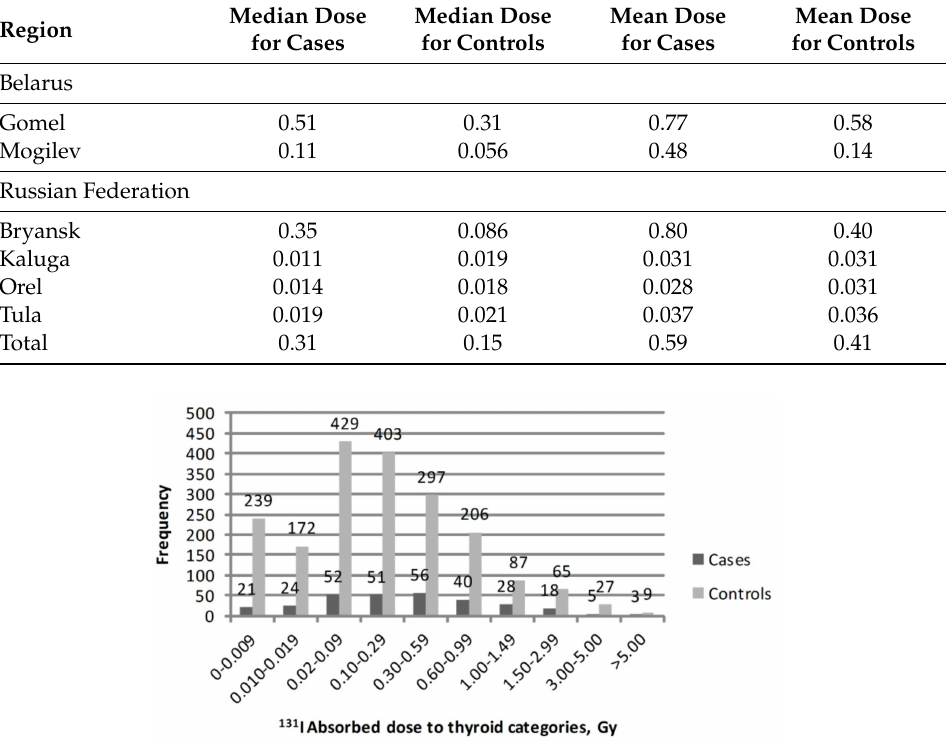
Figure 1. Frequency distribution of study cases and controls by categories of 131 I absorbed thyroid